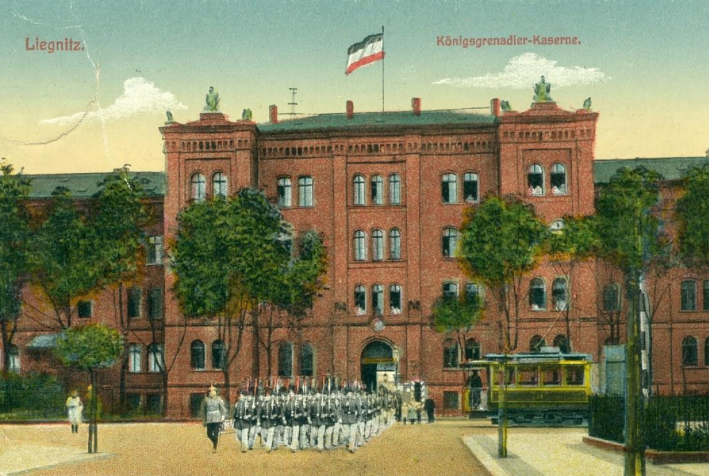
Figure 4. Period postcard showing The Grenadier barracks (from the author’s collection) in 1917, published by M.U.L (complex no 5 in Figure 1).